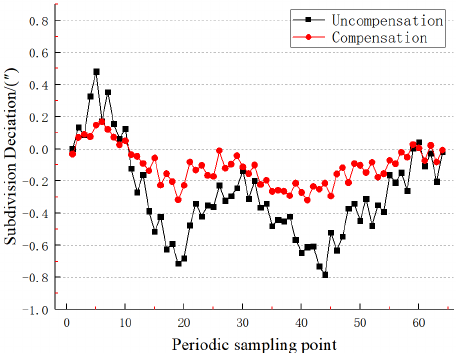
Figure 19. Comparison before and after static subdivision error compensation.